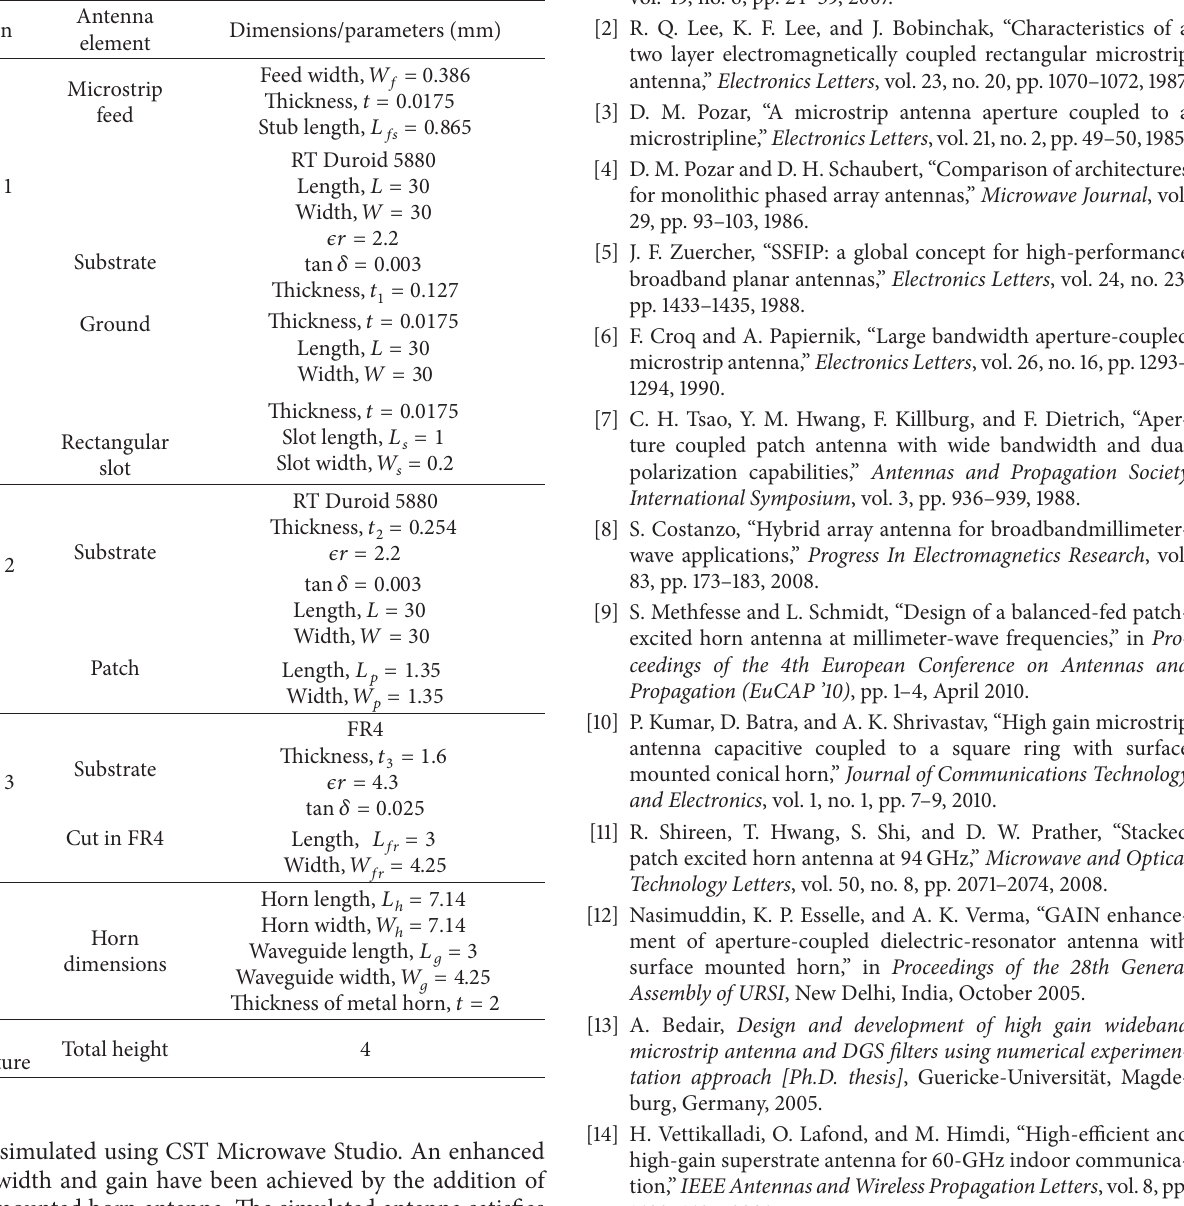
Table 1: Parameters of the proposed antenna in